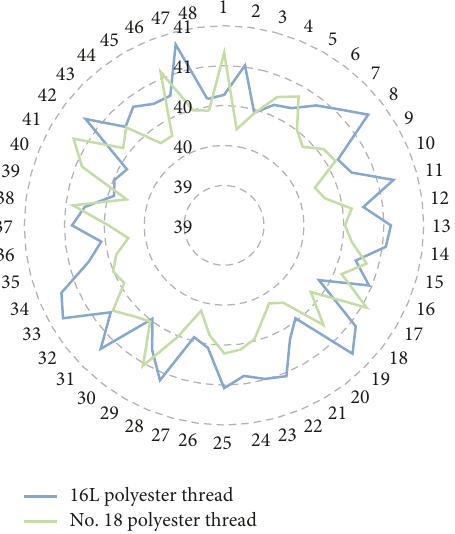
Figure 9: Statistical graphs of vibration frequency of racket swing in different string diameter